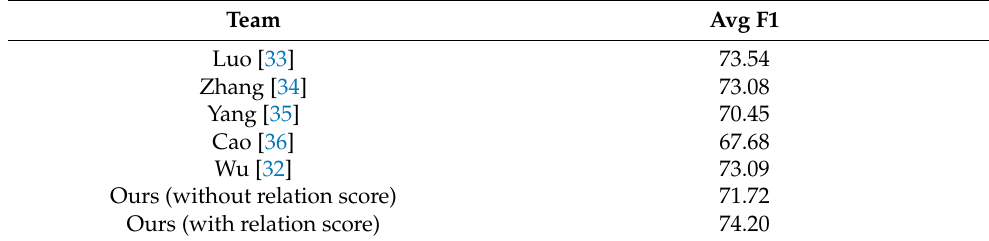
Table 5. The evaluation results on CCKS 2019 CKBQA